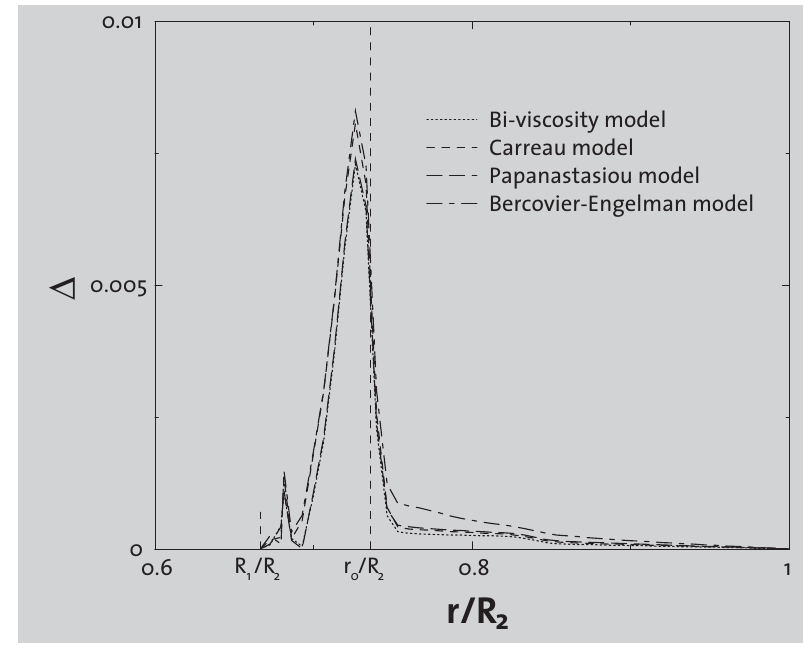
Figue 4 (above): Relative error for tangential velocity in Couette flow.